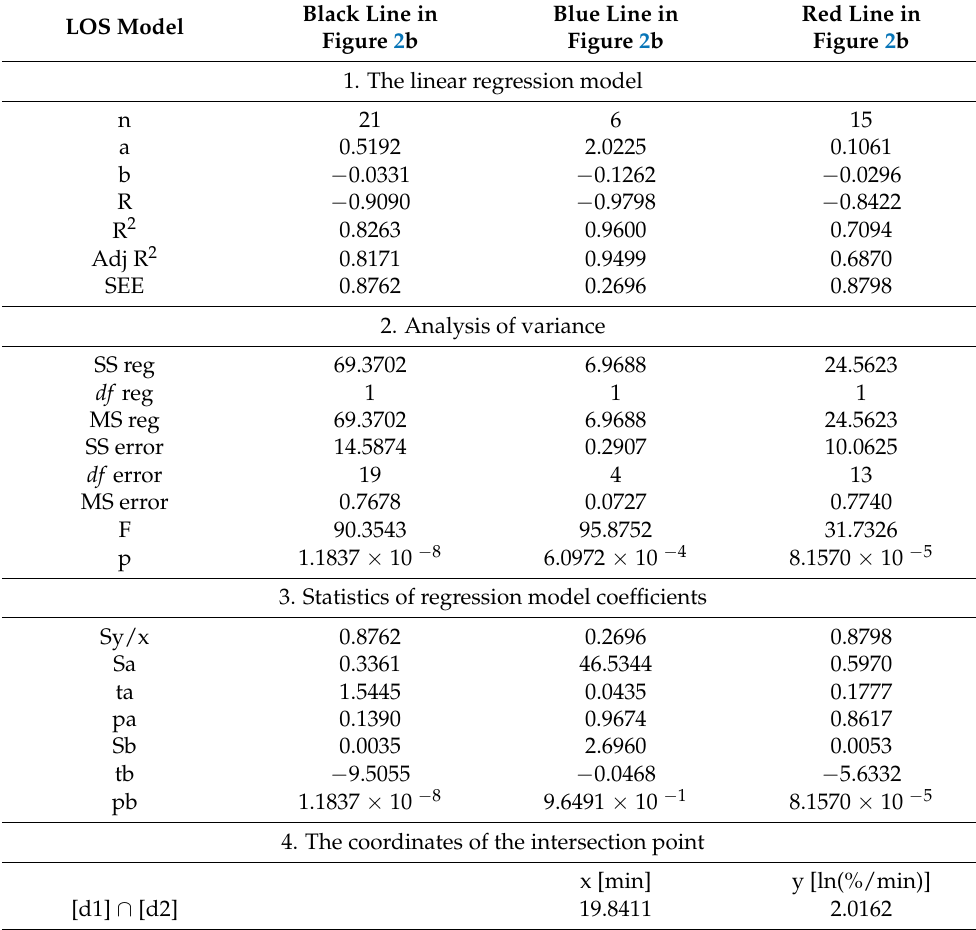
Table 5. The parameters associated with the four directions considered to characterise the first replica the Figure 2b. LOS Model